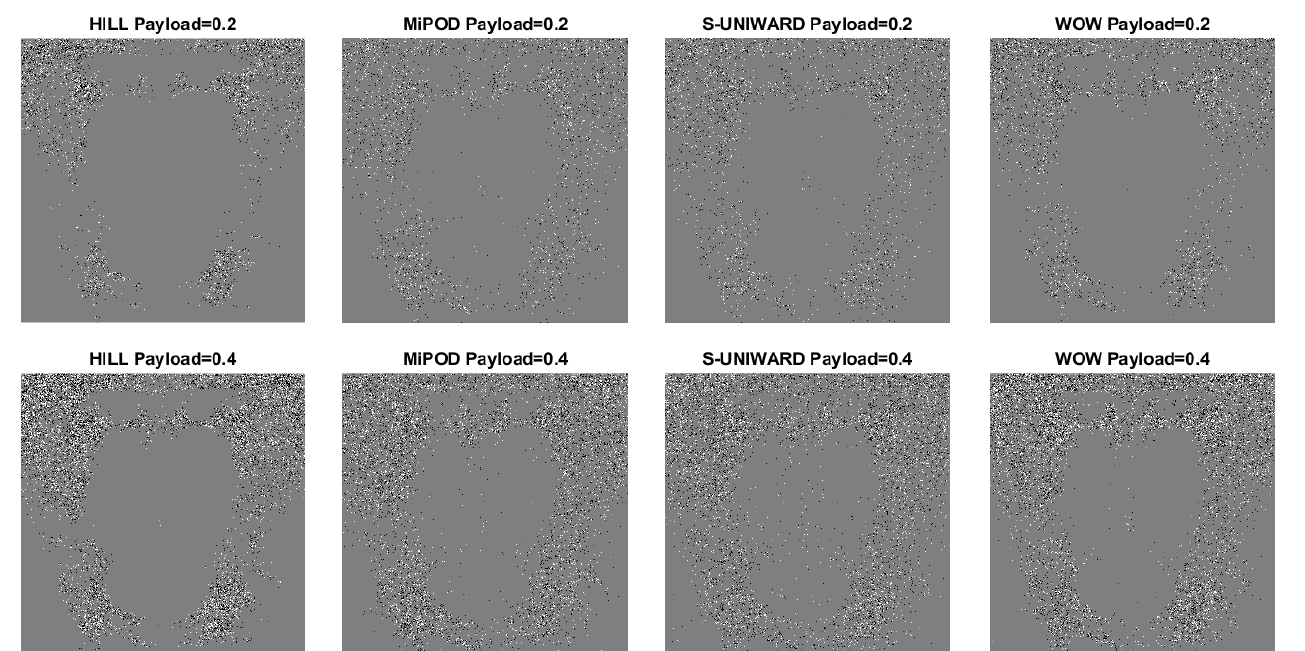
Figure 1. Cover image with residual arrays of cover and stego images.